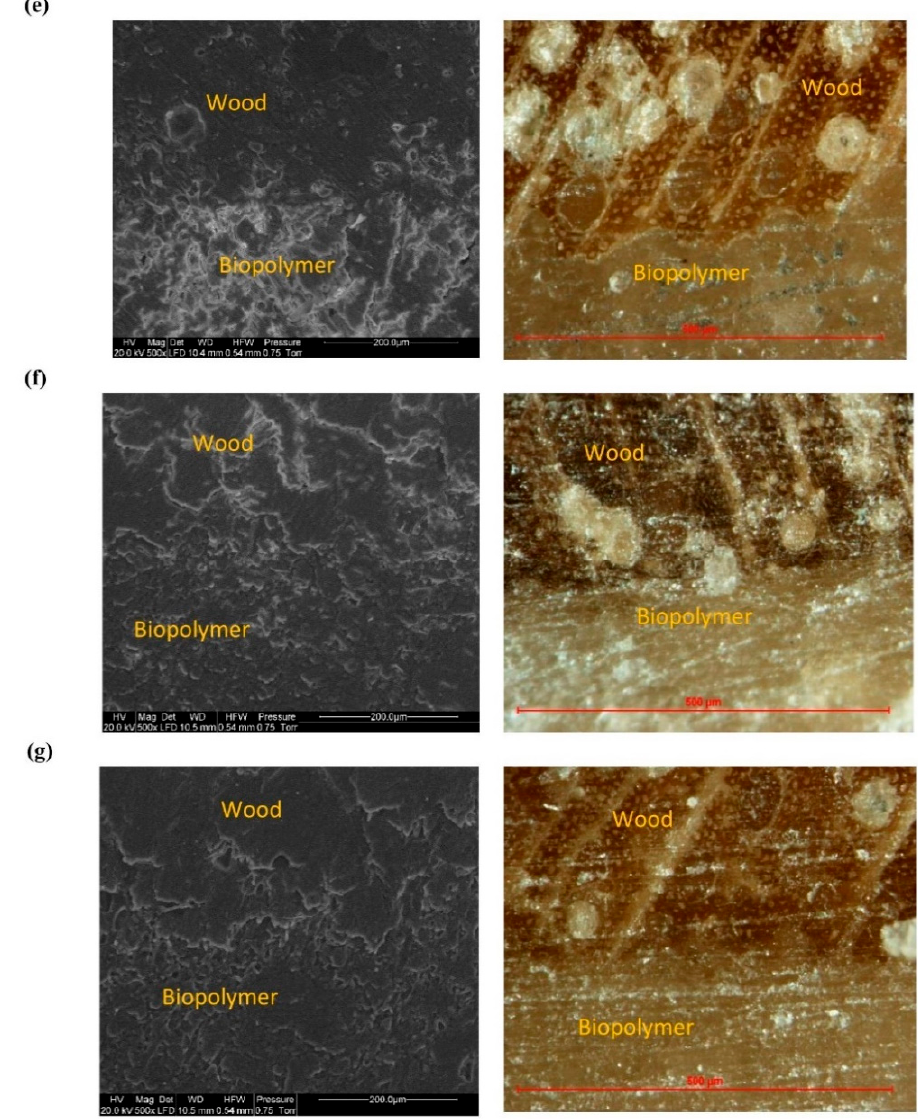
Figure 8. ( A ) SEM pictures ( × 500) and ( B ) optical microscope photos of the cross-section of composites (10 × ): ( a ) PLA, ( b ) PCL, ( c ) PLA + PHB, ( d ) PLA + PHB + 25MCC, ( e ) PLA + PHB + 25MCC + 3TEC, ( f ) PLA + PHB + 50MCC, ( g ) PLA + PHB + 50MCC + 3TEC. The wood and binder layers are indicated in the pictures.